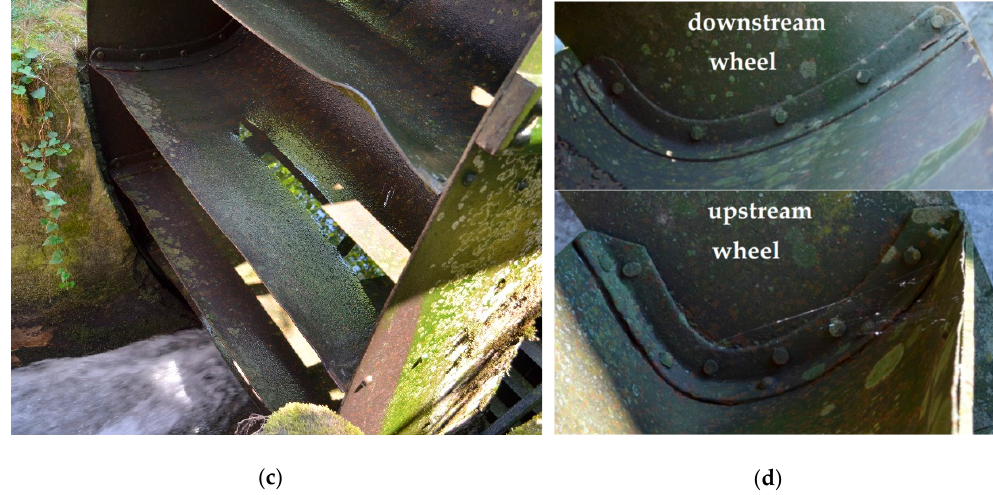
Figure 6. The low breastshot water wheels of the Forno mill: ( a ) Overall view; ( b ) side view and particular of the worn plain bearing; ( c ) water entry point; ( d ) shape of the blades.